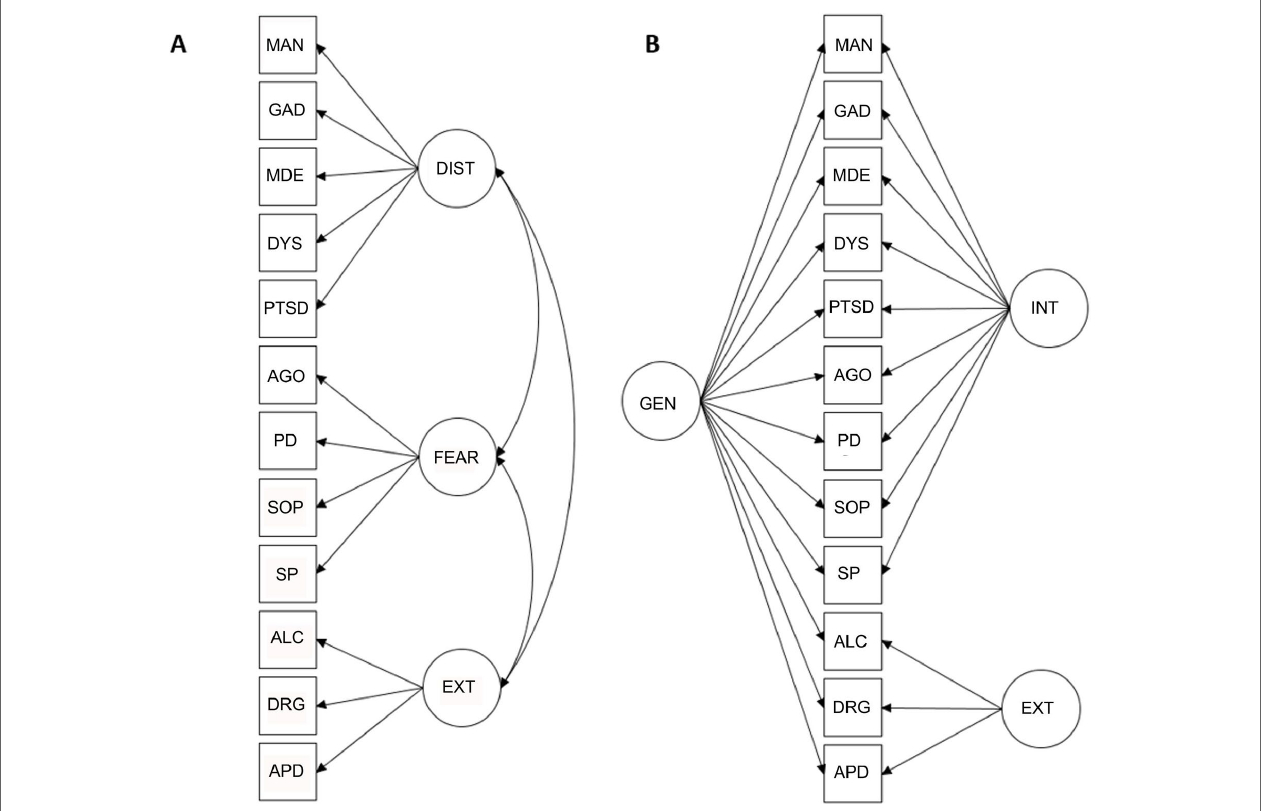
FIGURE 1 | Simplified representations of the correlated factors model (A) and the bifactor model (B) . MAN, mania; GAD, generalized anxiety disorder; MDE, major depressive episode; DYS, dysthymia; PSTD, posttraumatic stress disorder; AGO, agoraphobia; PD, panic disorder; SOP, social phobia; SP, specific phobia; ALC, alcohol abuse; DRG, drug abuse; APD, antisocial personality disorder; DIST, distress; EXT, externalizing; INT, internalizing; GEN,